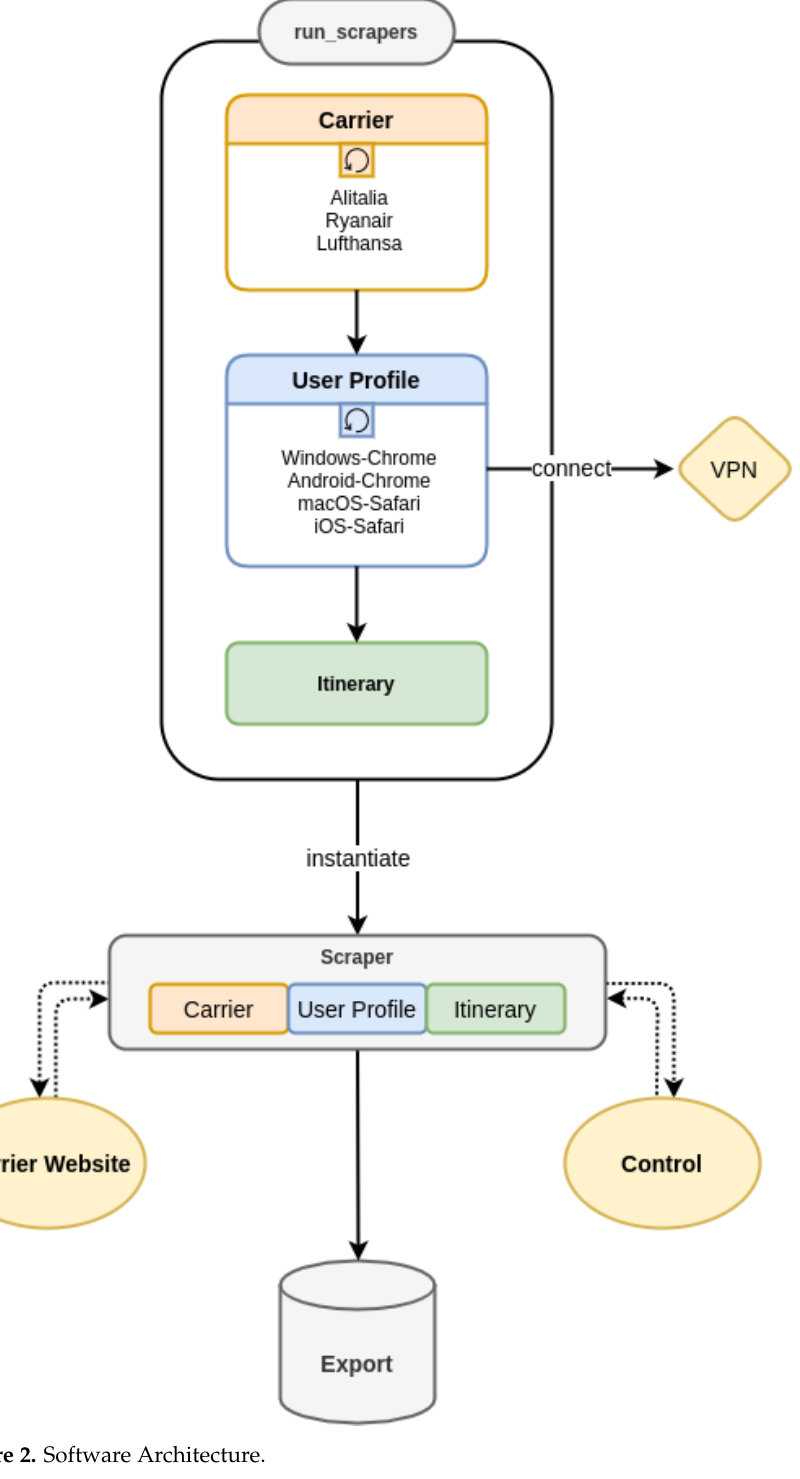
Figure 2. Software